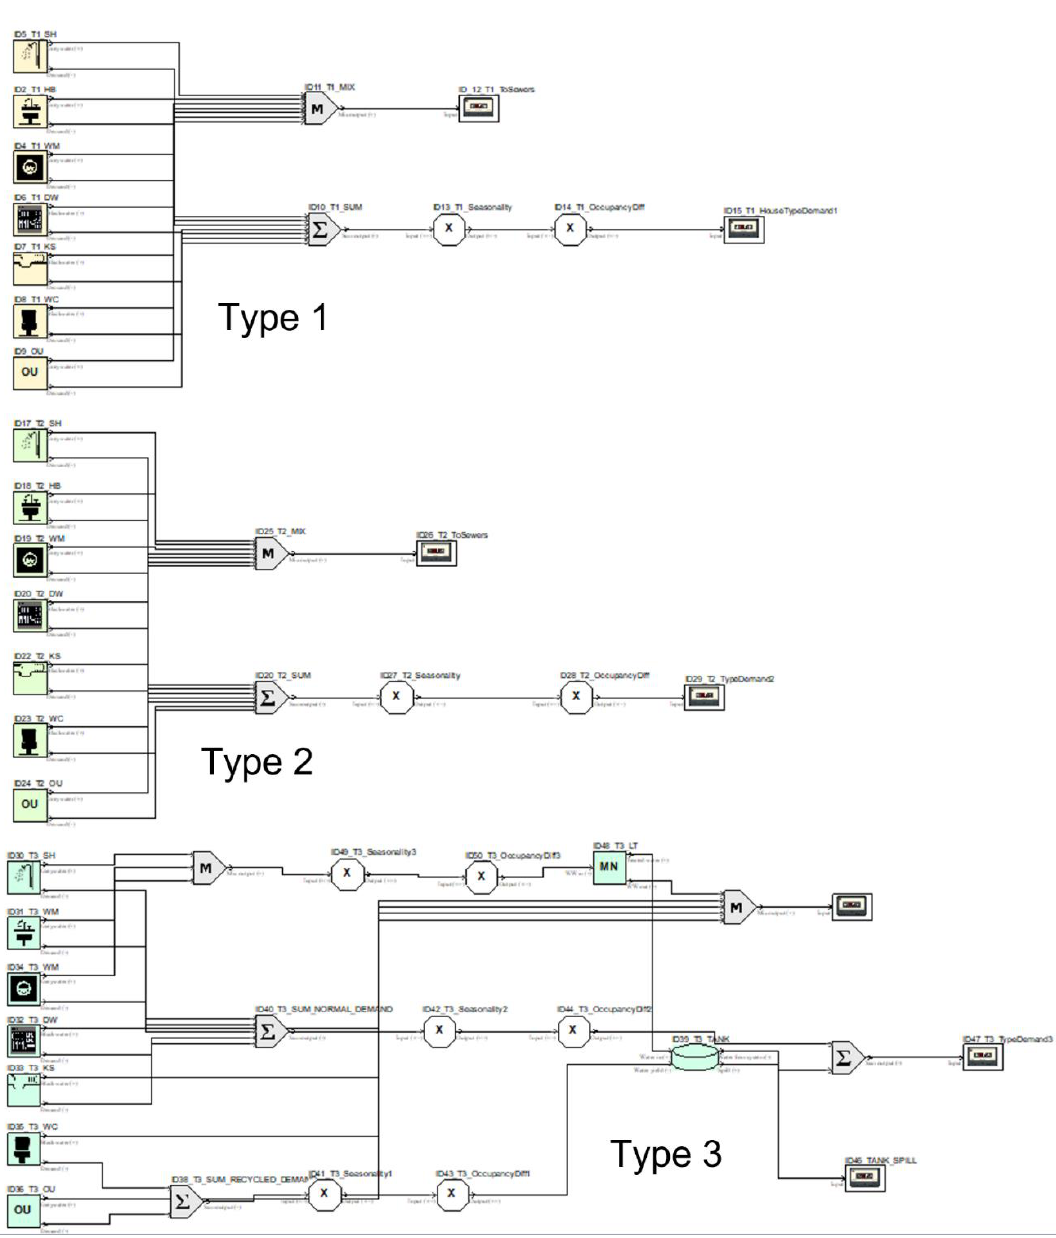
Figure 5. UWOT modeling of the three household types.